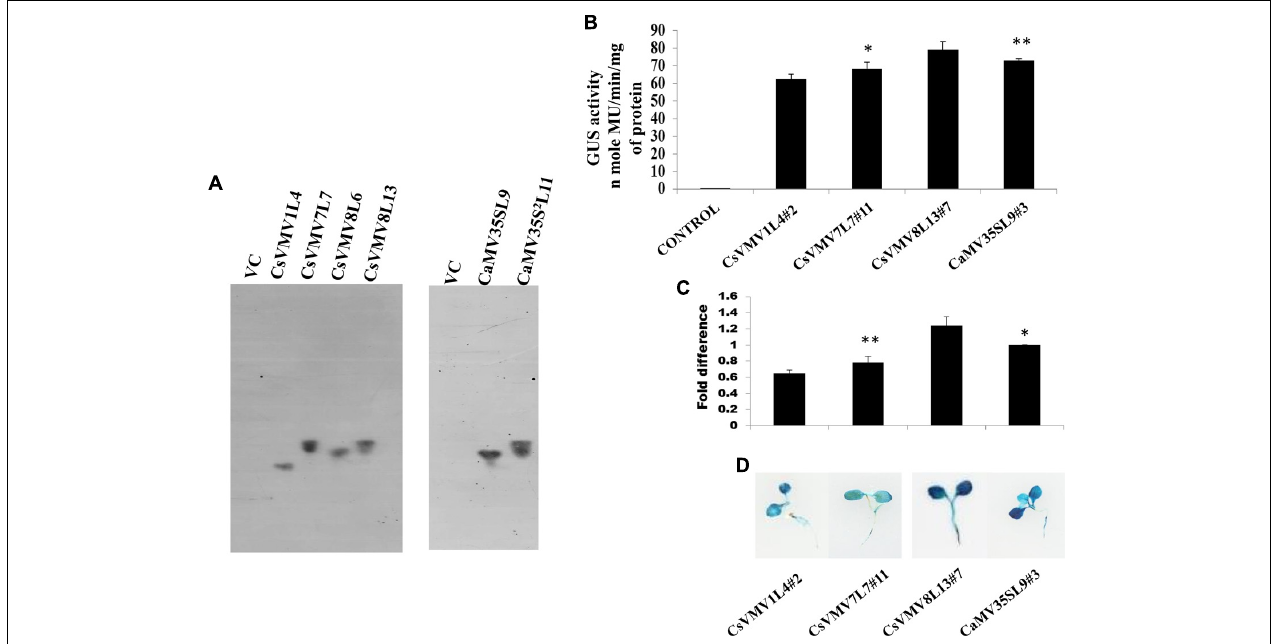
FIGURE 2 | Transgenic activity analyses of CsVMV1L4, CsVMV7L7, CsVMV8L13, and CaMV35SL9. (A) Southern blot analyses to investigate the copy number of uidA gene in transgenic tobacco lines (T 1 generation). (B) Stable transgenic GUS expression analyses of the above promoter constructs were presented with their corresponding SD. (C) Relative fold difference of uidA transcript levels in 21-day old transgenic seedlings under the control of respective promoter fragments. (D) Images of X-Gluc stained whole seedlings (T 2 generation) expressing CsVMV1L4#2, CsVMV7L7#11, CsVMV8L13#7, and CaMV35SL9#3 promoters coupled to GUS reporter gene. Asterisks indicate level of significance where “ ∗∗ ” is more significant than “ ∗